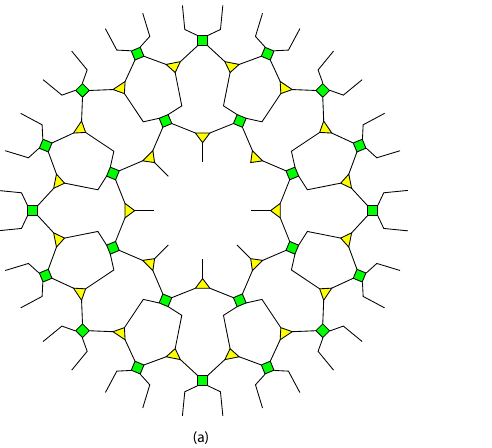
Figure 11 . Another representation of the resulting tensor network, which is more appropriate to be identified with MERA-like tensor network. Note the difference of the component tensors of the two representations.